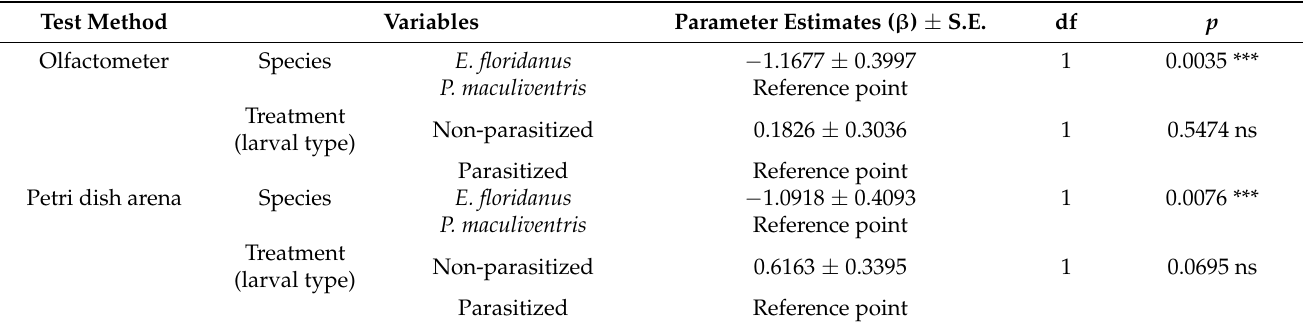
Table 5. Maximum likelihood estimates for fall armyworm larval choice (parasitized or non- parasitized) by predators Podisus maculiventris and Euthyrhynchus floridanus